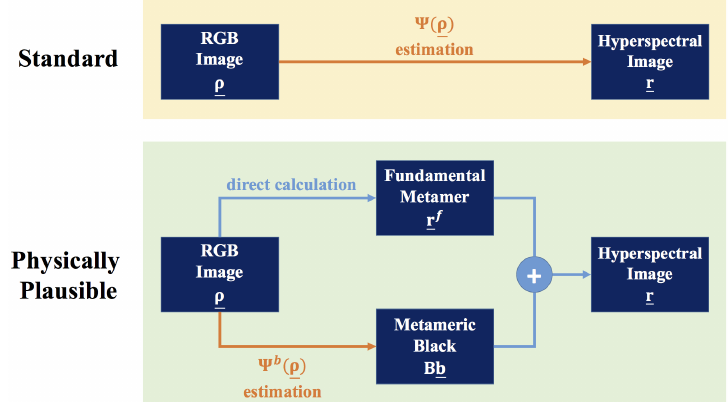
Figure 7. The standard SR scheme ( top ) versus our physically plausible SR scheme ( bottom